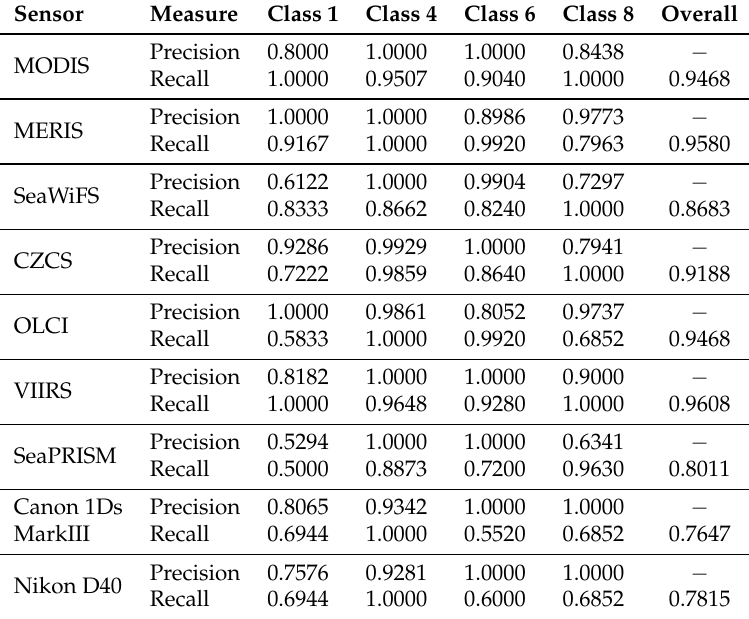
Table 4. Classification results using the proposed algorithm for Dataset